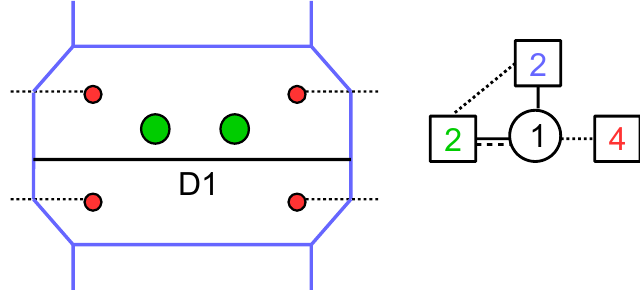
Figure 6 . Complete brane setup for the L 1 bubbling and improved SQM